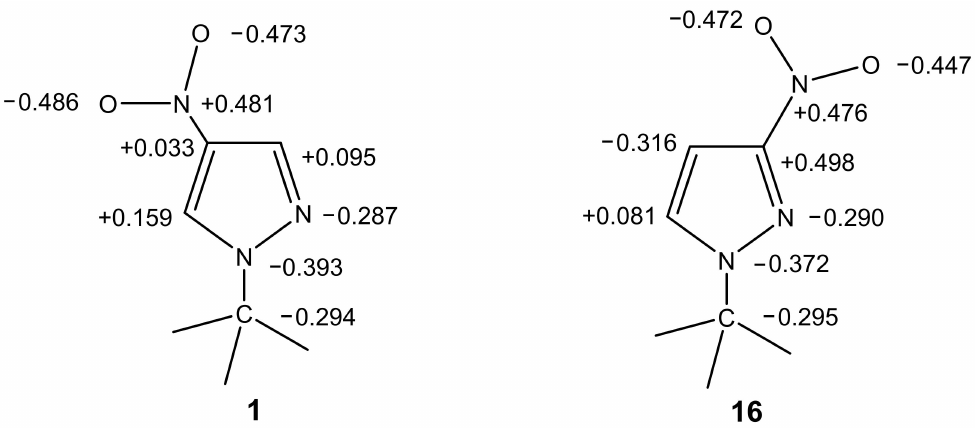
Figure 1. The charges at the atoms in the molecules of 1-methyl-4-nitropyrazole and 1-methyl-3- nitropyrazole according to ab initio B3LYP/6-31G